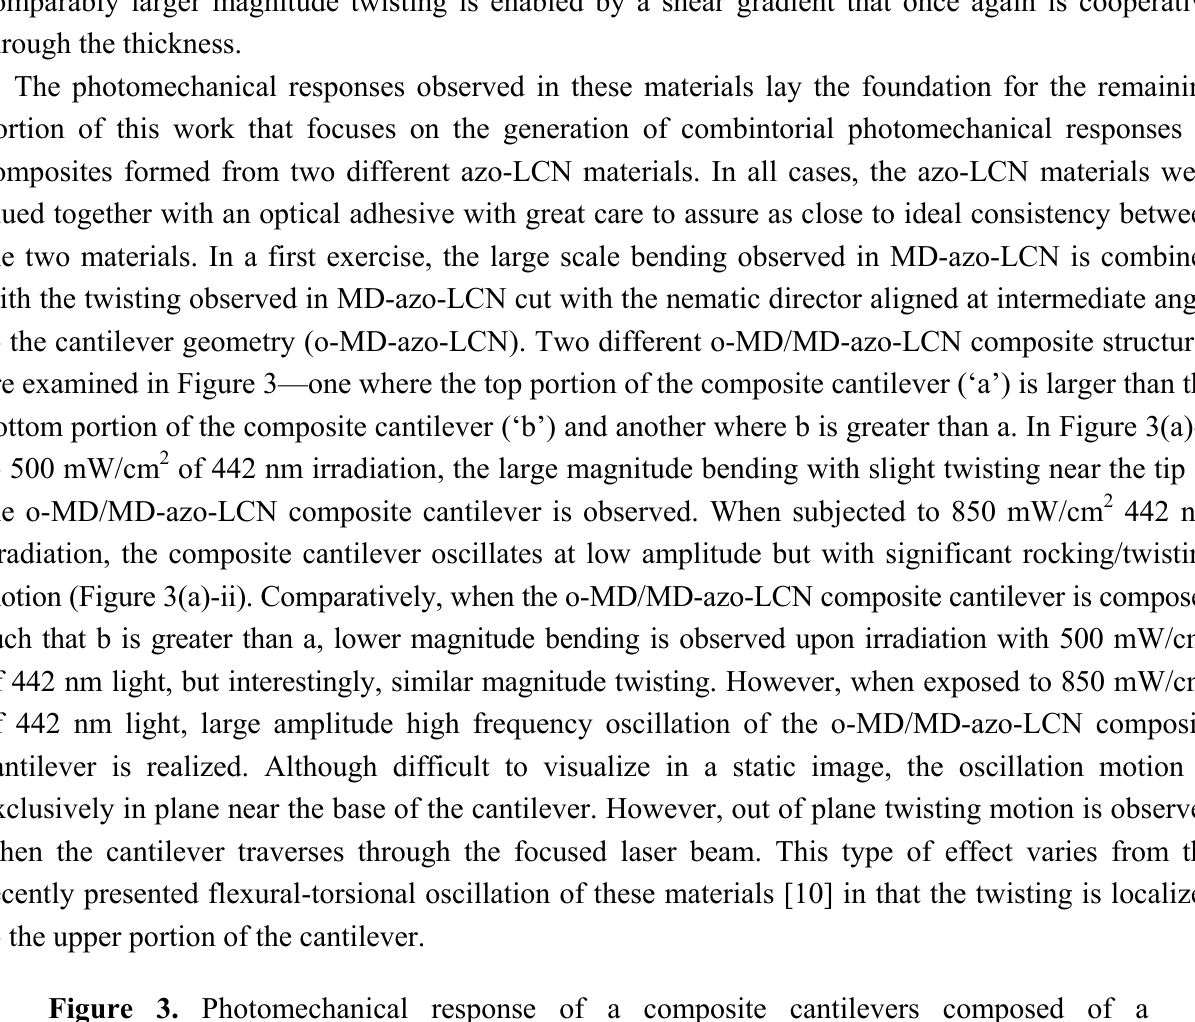
Figure 3. Photomechanical response of a composite cantilevers composed of